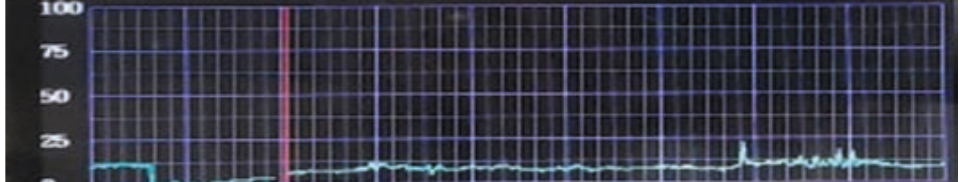
Fig. 2 Non-invasive tocodynamic monitoring-Complete primary uterine intertia